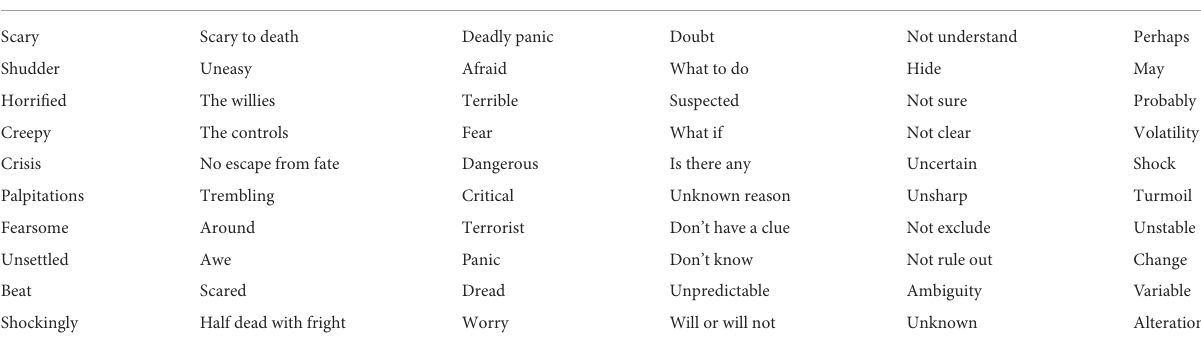
TABLE 1 Example of risk perception